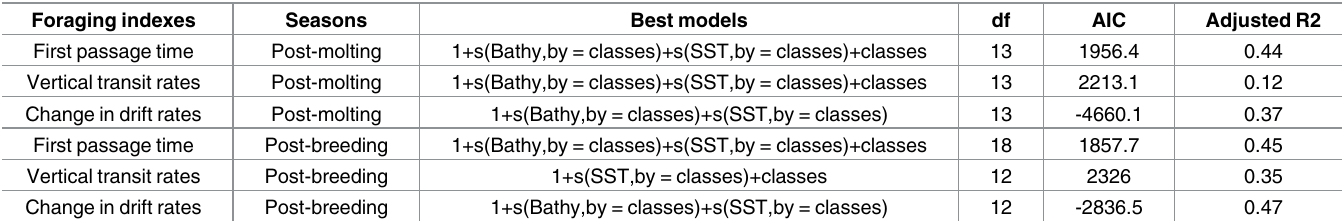
Table 4. Hooded seal habitat preferences identified using GAMMs. Bathymetry (Bathy), sea surface temperature(SST) and the age/sex classes (i.e. Pups, Femalesand Males) were explored. Foraging